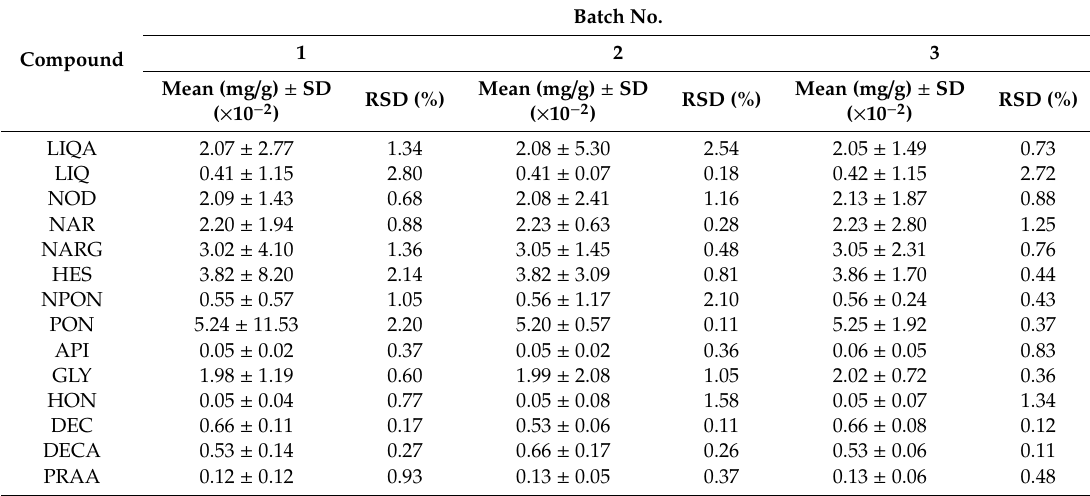
Table 4. Amount of the 14 marker components in SDGT based on HPLC–PDA analysis ( n = 3).